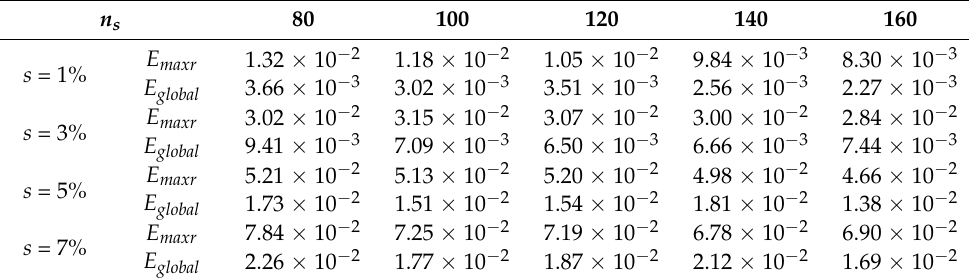
Table 4. The numerical errors with different number of local